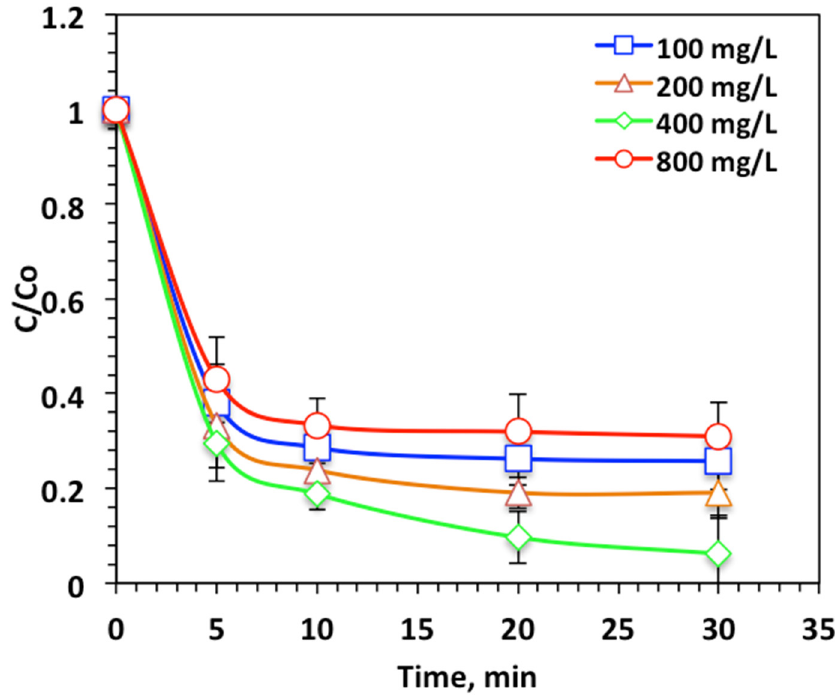
Figure 6. Effect of hydrogen peroxide loading on photo-Fenton-like oxidation-based WSD:Mag system.